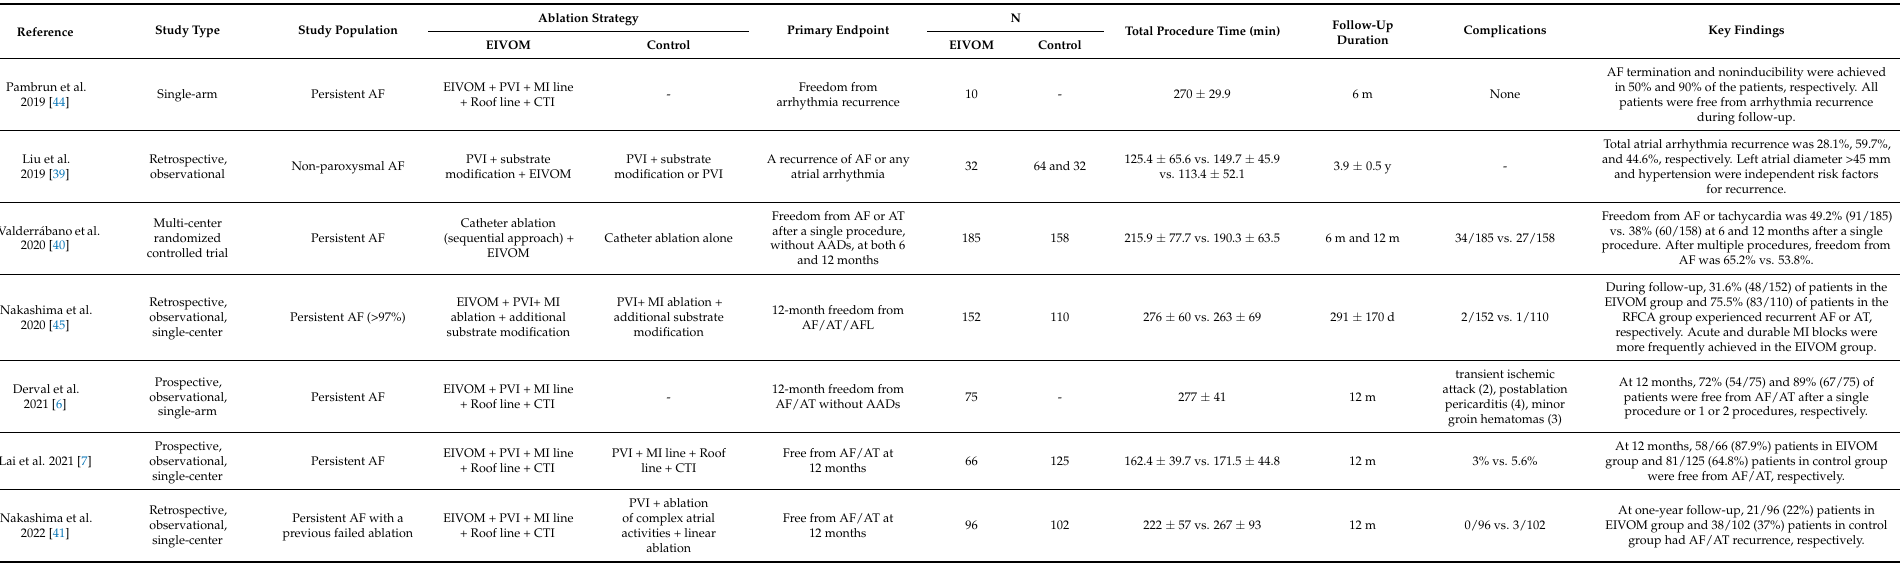
Table 1. Summary of clinical studies of EIVOM in